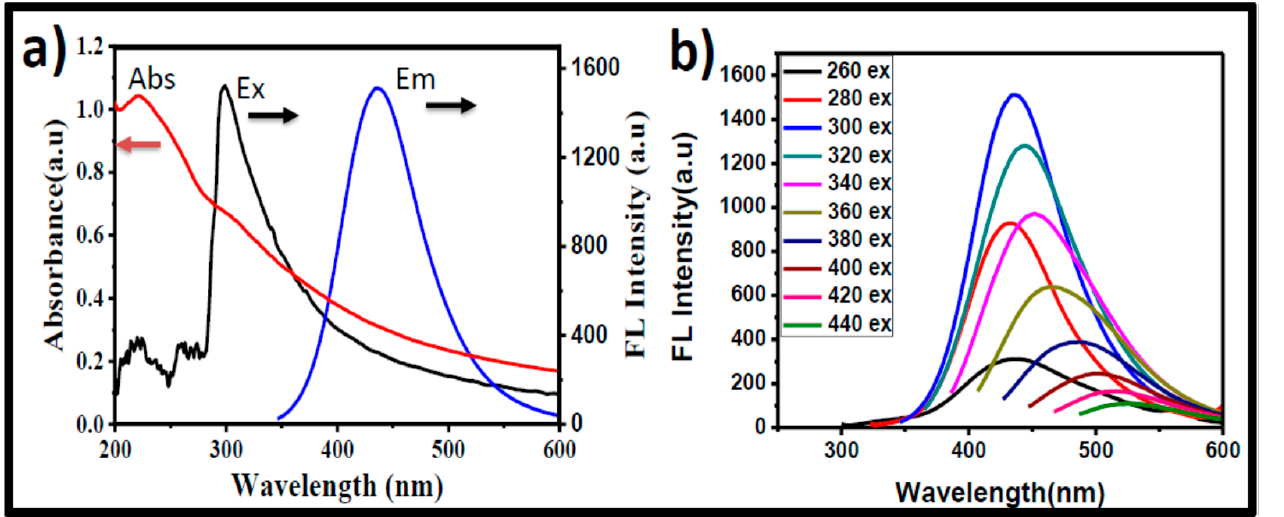
8 of 16 Figure 3. ( a ) FTIR spectra of synthesized GOQDs. ( b ) XPS survey spectrum of GOQDs. ( c ) C1s de- convolution XPS spectra of GOQDs. ( d ) O1s deconvolution XPS spectra of GOQDs. The black color line is for the original spectrum and the other colored lines are the deconvoluted spectral lines in both subfigures c and d. 3.2. Optical Properties of GOQDs Figure 4a depicts the UV-Vis absorption of GOQDs solution showing that GOQDs displayed two characteristic absorption peaks related to the GO structure. The peak at ~220 nm corresponding to π → π * transition is the indication of C=C and the peak at roughly 320 nm is related to n → π * transitions of C=O in GOQDs. The UV-Vis absorption consists of excitation and emission peaks at 300 nm and 440 nm. The blue PL emission characteristic of GOQDs was then examined. The synthesized GOQDs displayed maxi- mum emission at 440 nm when excited with a wavelength of 320 nm, as shown in Figure 4b. The FL quantum yield was determined by using the reference compound quinine sul-